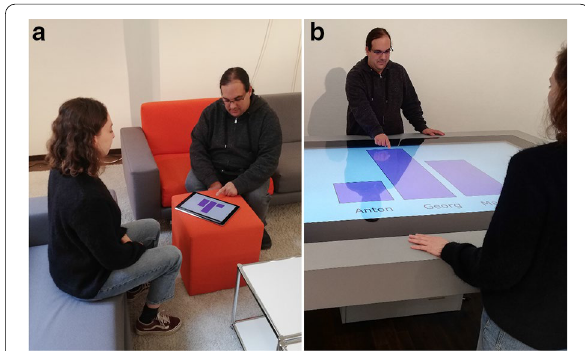
Fig. 1 Illustration of the collaborative settings with shared displays. a Two users study the same information on an iPad. b Two users collaborate using a multi-touch table, an interactive tool for group collaborations. In both scenarios, the display is rotated for one of the